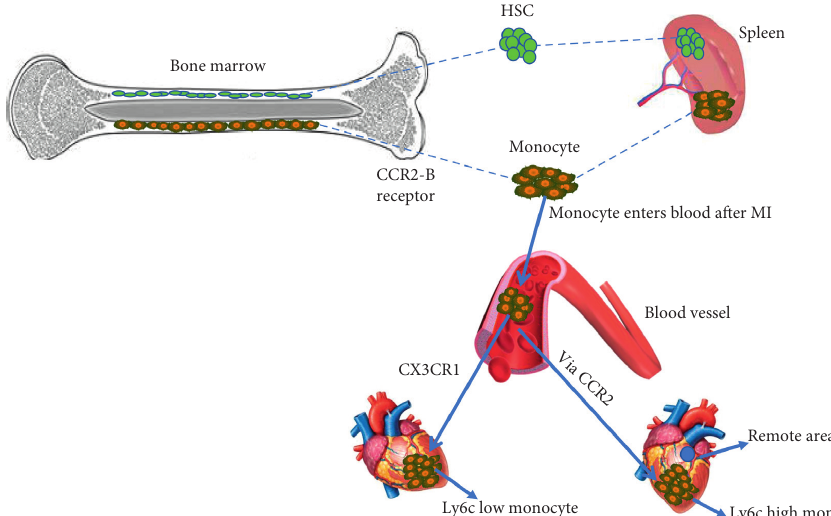
Figure 2: Macrophages in a failing